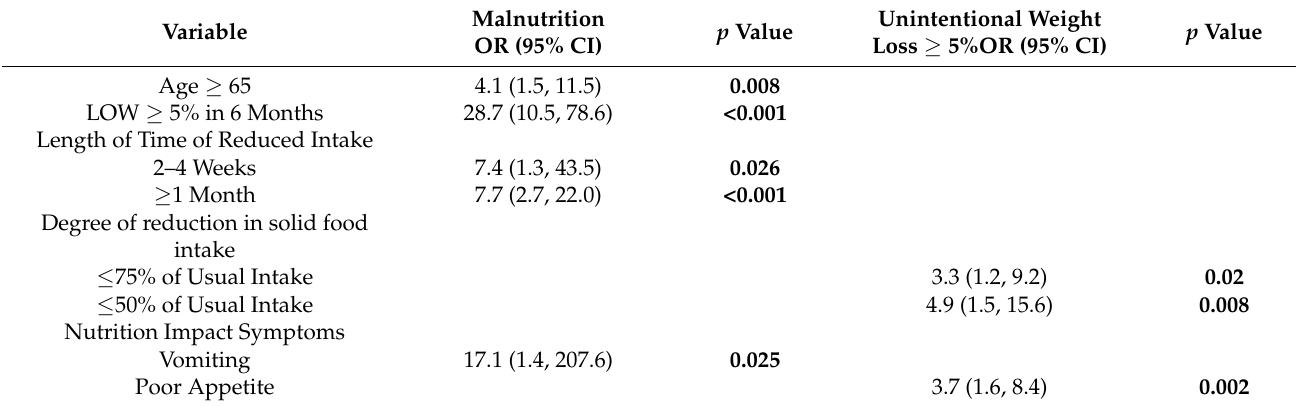
Table 5. Factors independently associated with malnutrition and weight loss ≥ 5% by multivariate analysis ( n =